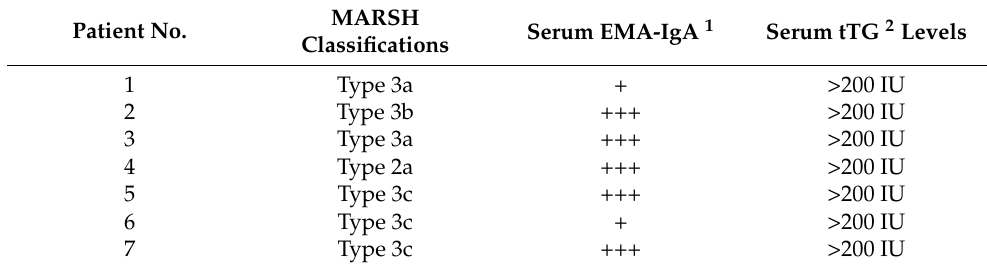
Table 1. MARSH classification of celiac disease patients. MARSH Patient No. Serum EMA-IgA 1 Serum tTG 2 Classifications